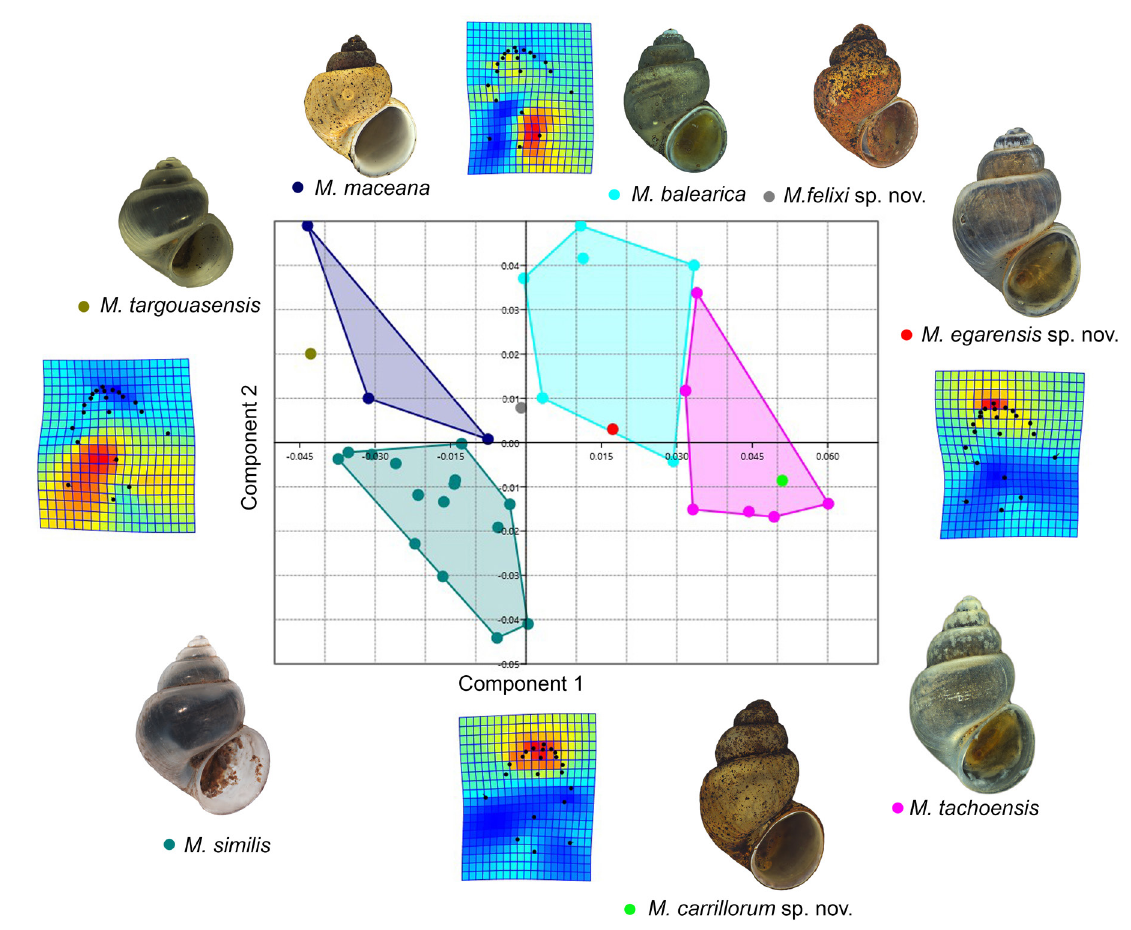
Fig. 3. Principal components analysis plot for species of Mercuria Boeters, 1971 based on 21 coordinates (9 landmarks and 12 semilandmarks). Each dot on the plot represents the consensus of the shape of each of the sampled populations. Warp grid deformations (TPS) show expansion (in red colour) and contraction (in blue) of the shell